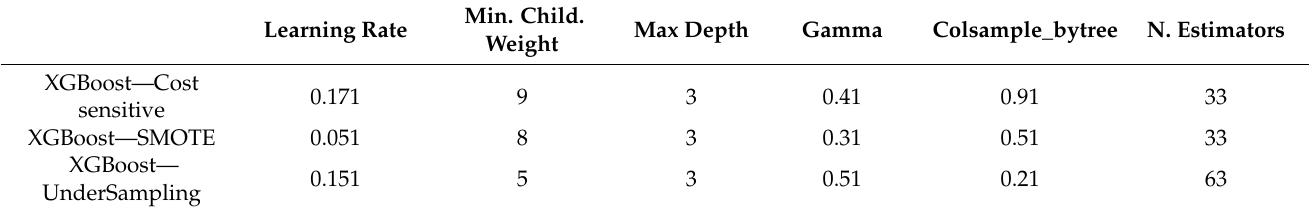
Table 5. Hyperparameters identified by the random search optimization procedure of the